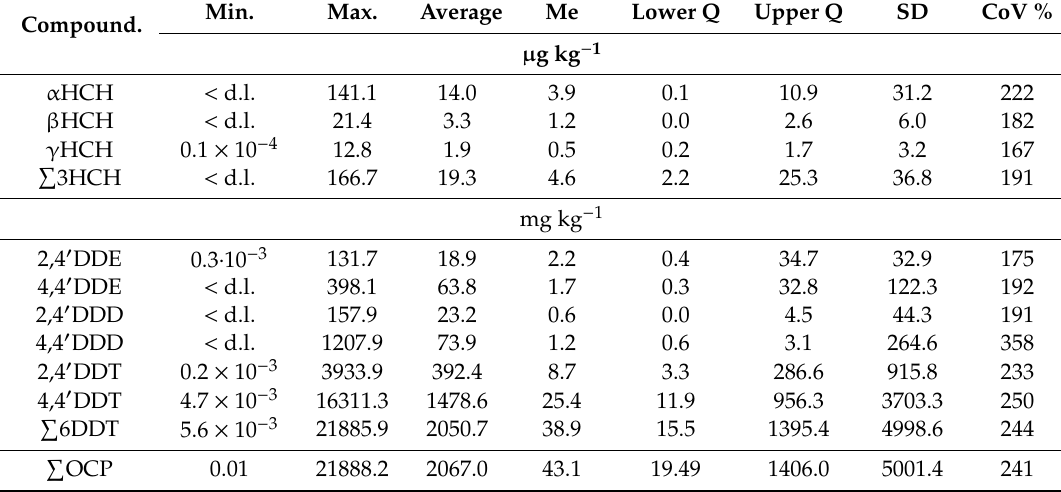
n.d.—notdefined,Min.—thelowestcontentofthetestcompound,abovethedetectionlimit,Max—thehighestcontent of the analyzed compounds, Me—median, Lower Q—lower quartile, Upper Q—upper quartile, SD—standard deviation, CoV—coe ffi cient of variation, n—number of samples, and < d.l.—below detection